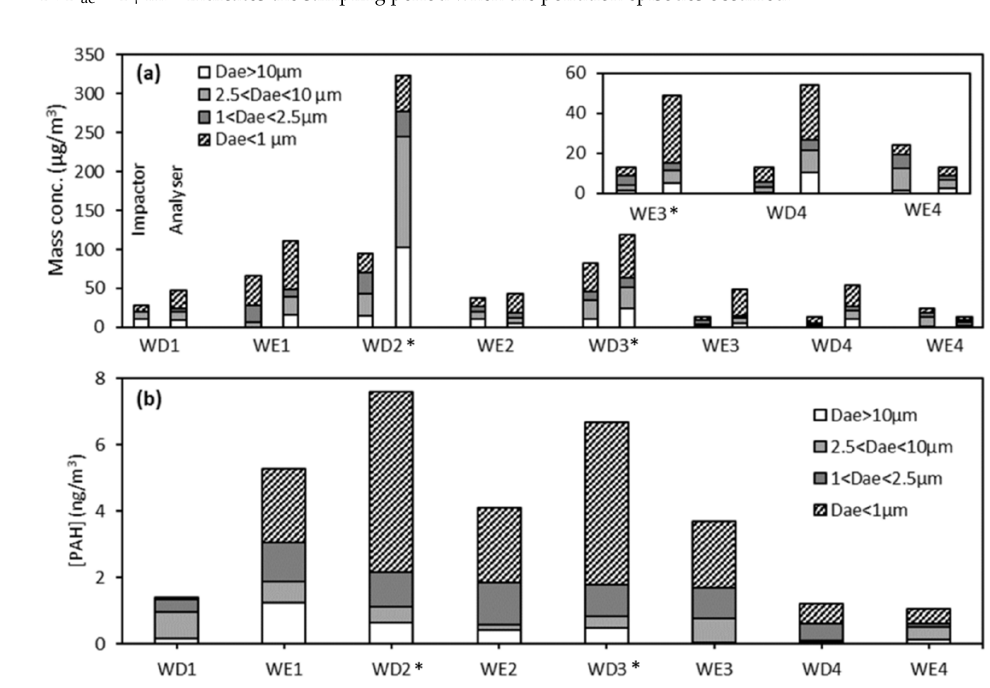
Table 2. Particle mass concentration in the different size ranges and PM values (µg/m 3 ).